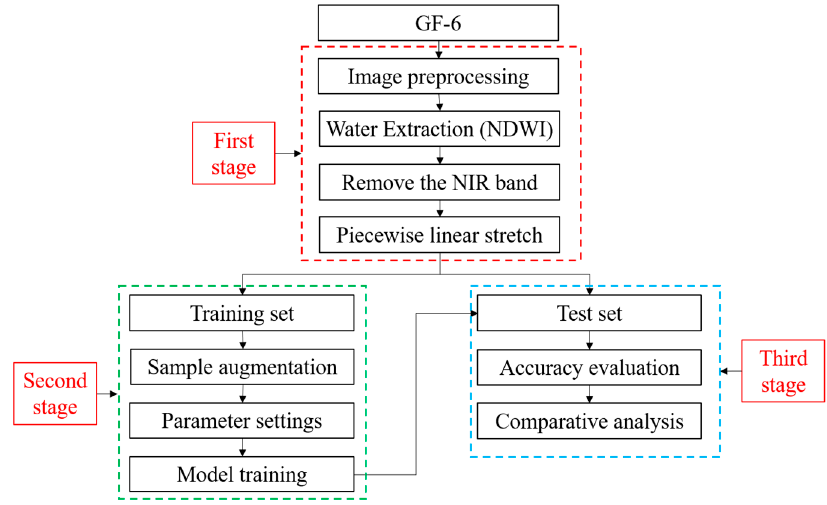
Figure 3. Flowchart of aquaculture zone extraction in this study.